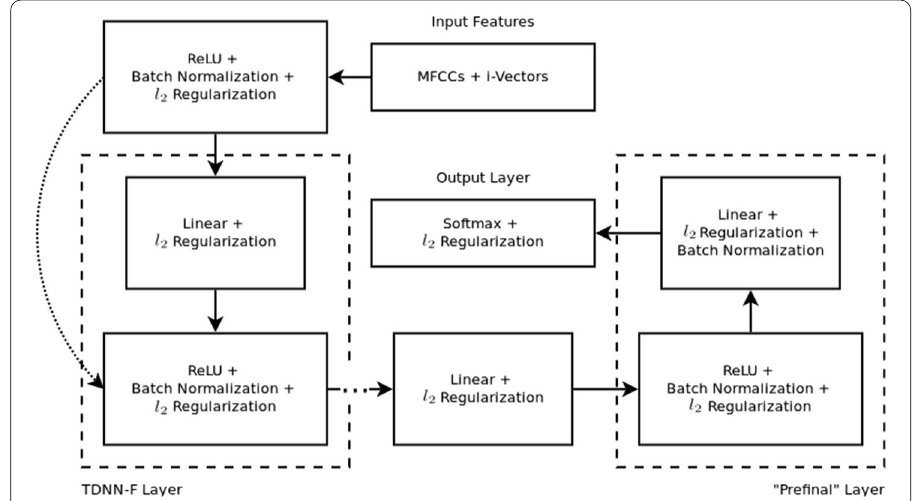
Fig. 4 Default architecture of the TDNN-F from Kaldi’s Mini-librispeech recipe. The setup is composed by multiple TDNN-F layers, although only one is being depicted. The dotted arrow represents a bypass connection similar to what happens in ResNet topologies. All layers but the output apply batch normalization, while l 2 regularization is applied without exception. Linear blocks are intentionally thinner by either being bottlenecks or just having a lower dimension with respect to other